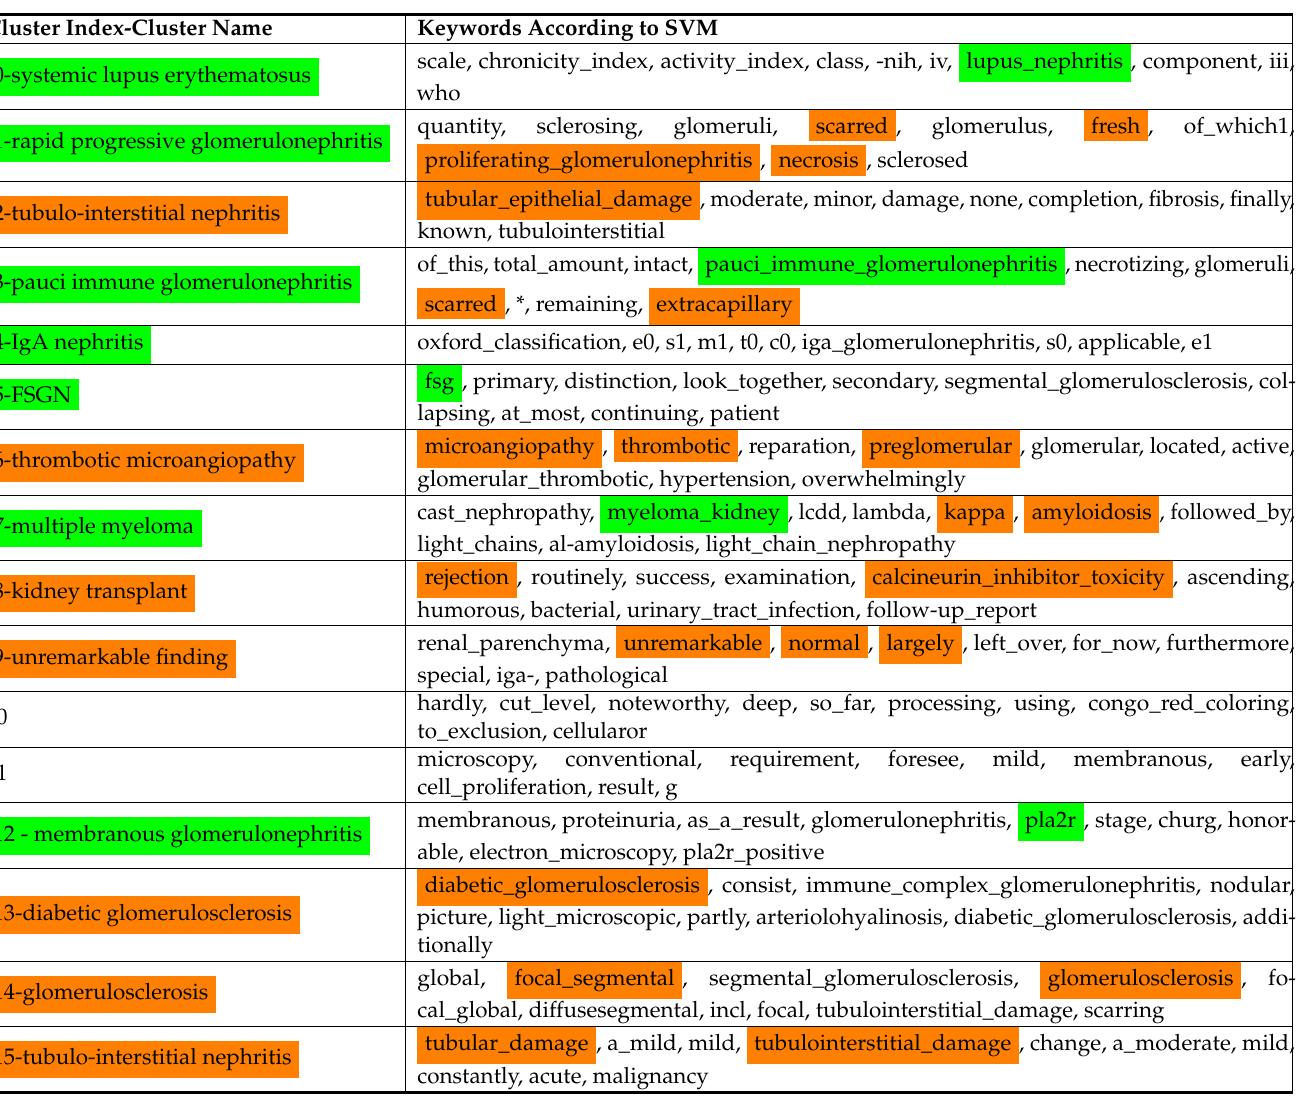
Table 3. Annotated topic words (translated from German to English), extracted from the HDBSCAN! ( HDBSCAN! ) cluster-set, using the SVM! ( SVM! ) based extraction method. A particularly large number of topic words strongly refer to cluster names (left column) highlighted in green (strong cluster names). In the case of cluster names marked in orange, only a few topic words indicated the specified cluster name (weak cluster name). The same applies to the colour-coded topic words: topic words that strongly indicate a cluster name are highlighted in green (strong topic words). Orange highlighted topic words only weakly indicate a cluster name (weak topic